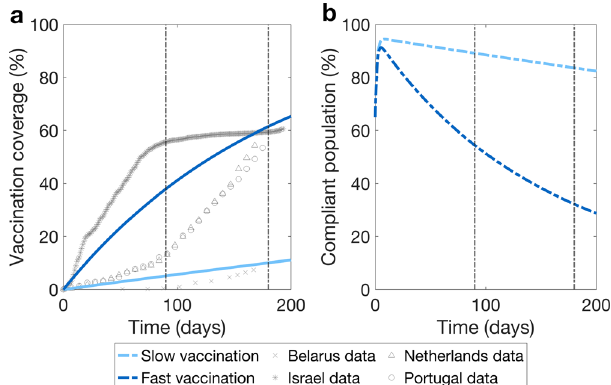
Fig. 2 Vaccination coverage and proportion of compliant population during the vaccination rollout. a Increase in vaccination coverage for slow (light blue line) and fast (dark blue line) vaccination rates. Light grey markers show vaccination coverage for Belarus (crosses), Israel (stars), Netherlands (triangles), and Portugal (circles), respectively 42 .Smooth lines are output curves of the model indicating the proportion of the total population vaccinated if the whole population was eligible for vaccination and was vaccinated at a rate calculated using these data points. b Decrease in the proportion of who complies with physical distancing measures for slow and fast vaccination and a fi xed incidence of infection (16,062 cases per day) observed in the Netherlands in the period used for the model calibration. Vertical brown lines mark three and six months since the start of